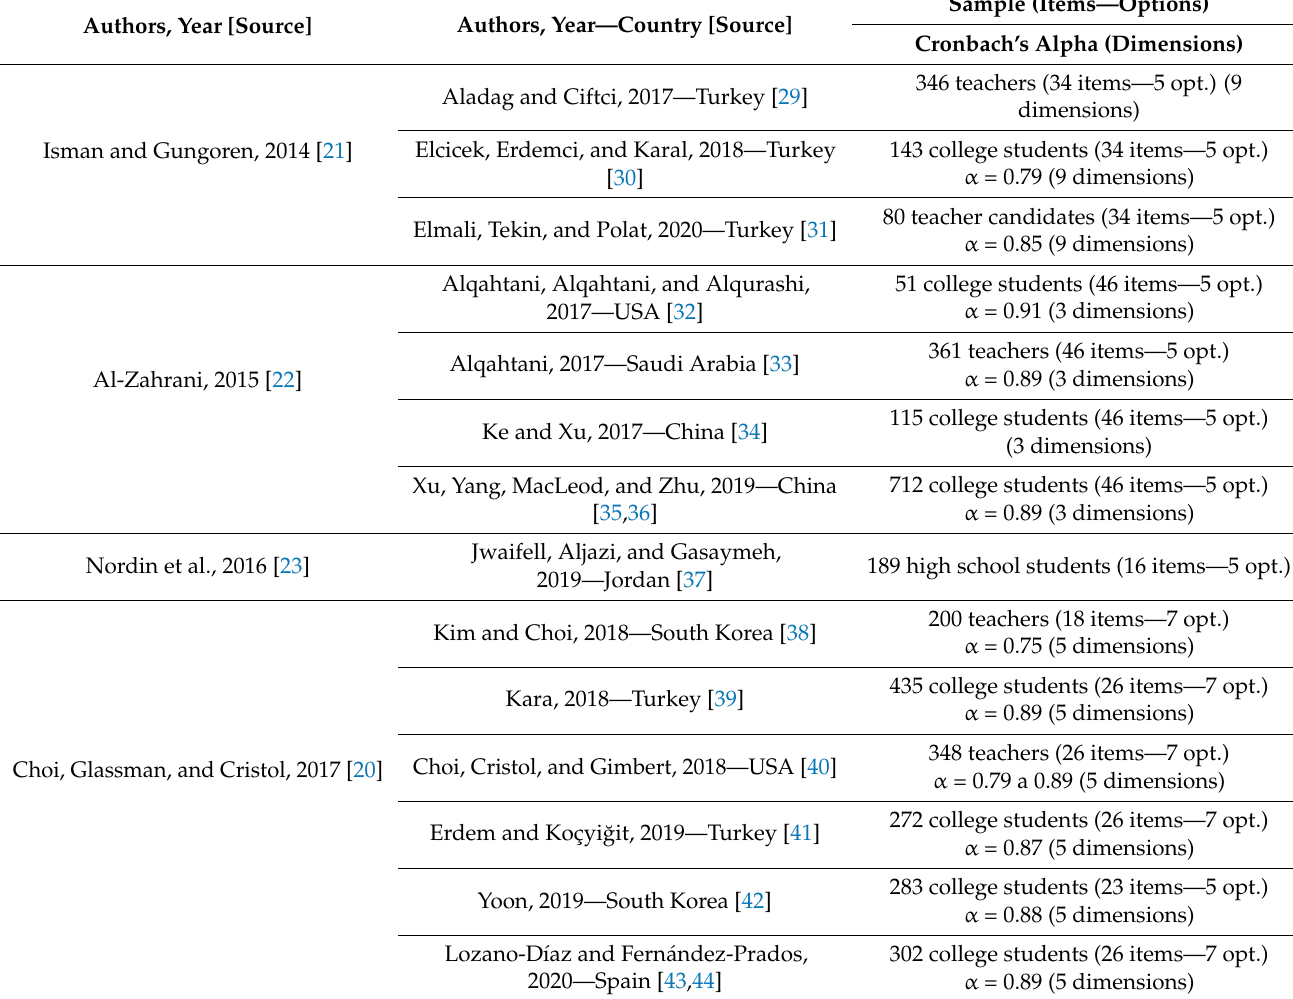
Table 3. Replications or adaptations of main digital citizenship